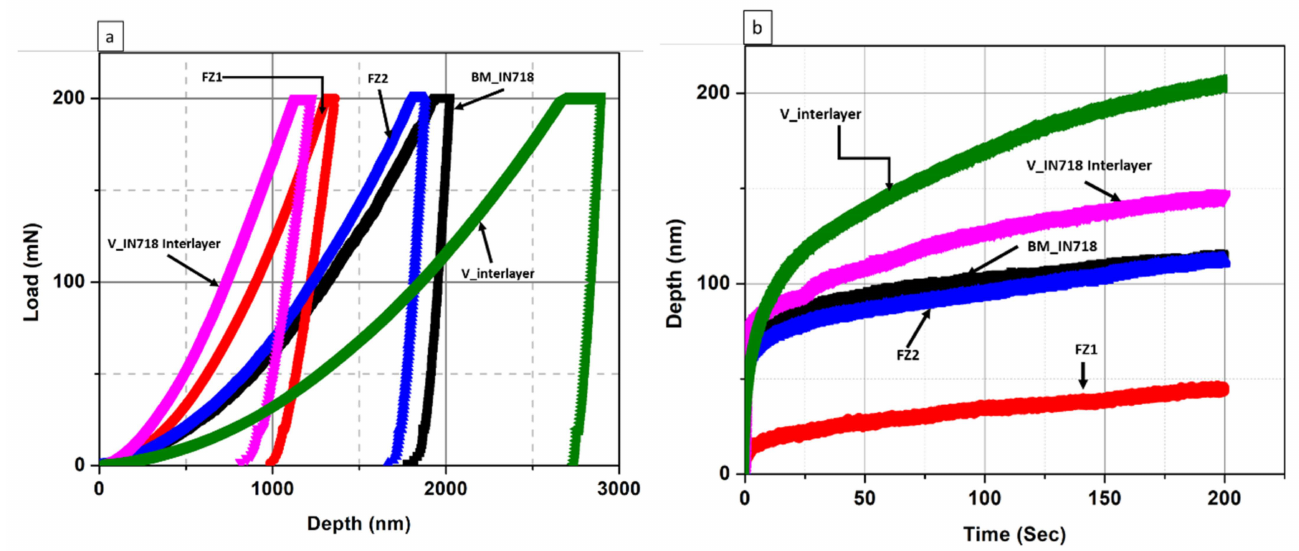
Figure 18. ( a ) The load–displacement (P–h) curves of different regions of V and IN718 obtained under 200 mN at 200 sec holding time. ( b ) The displacement–time (h–t) curves obtained in the holding regimes of different regions of V and the IN718